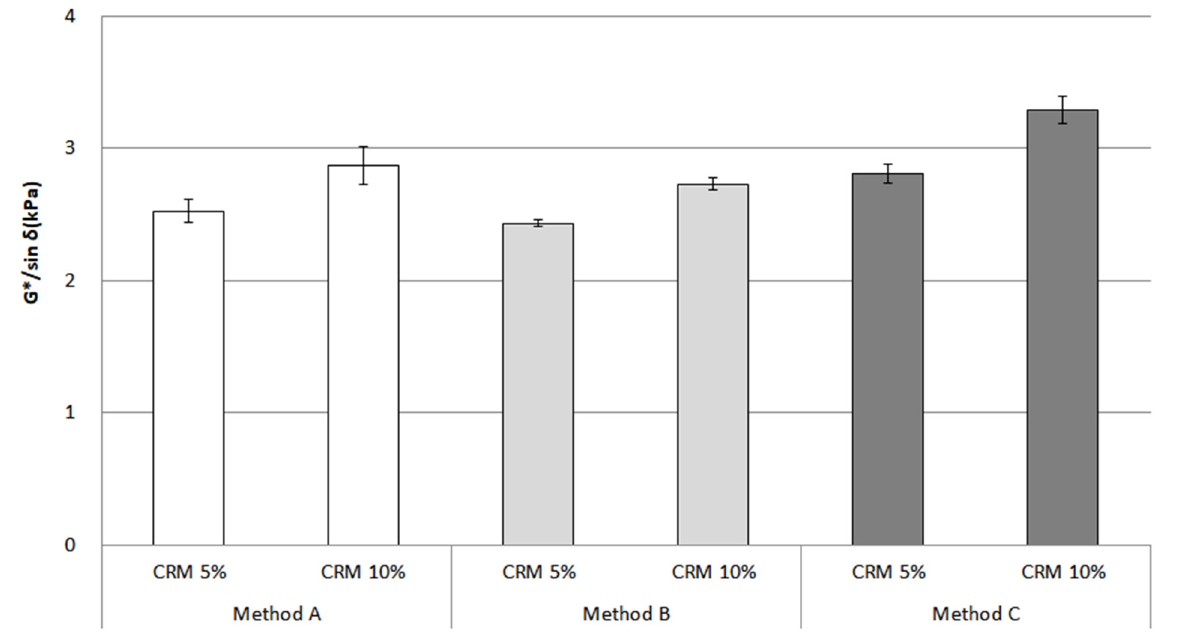
Figure 10. G*/sin δ of the CRM asphalt binders for each mixing method in the original condition.